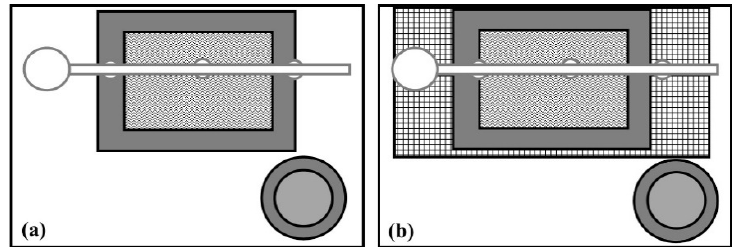
Figure 1. Top view of a mat filled with 1% povidone-iodine solution (MAT) ( a ) and the iodine mat placed on a slatted floor (SLAT) ( b ) pen-based flooring treatments. The pens contained a hanging drinker line (light grey), a metal feeder (dark grey circles), litter (white), a disinfection mat (dark grey rectangle border and patterned fill), and for the SLAT treatment, a plastic slatted floor (rectangle with black and white grid pattern). Illustration is not to scale.